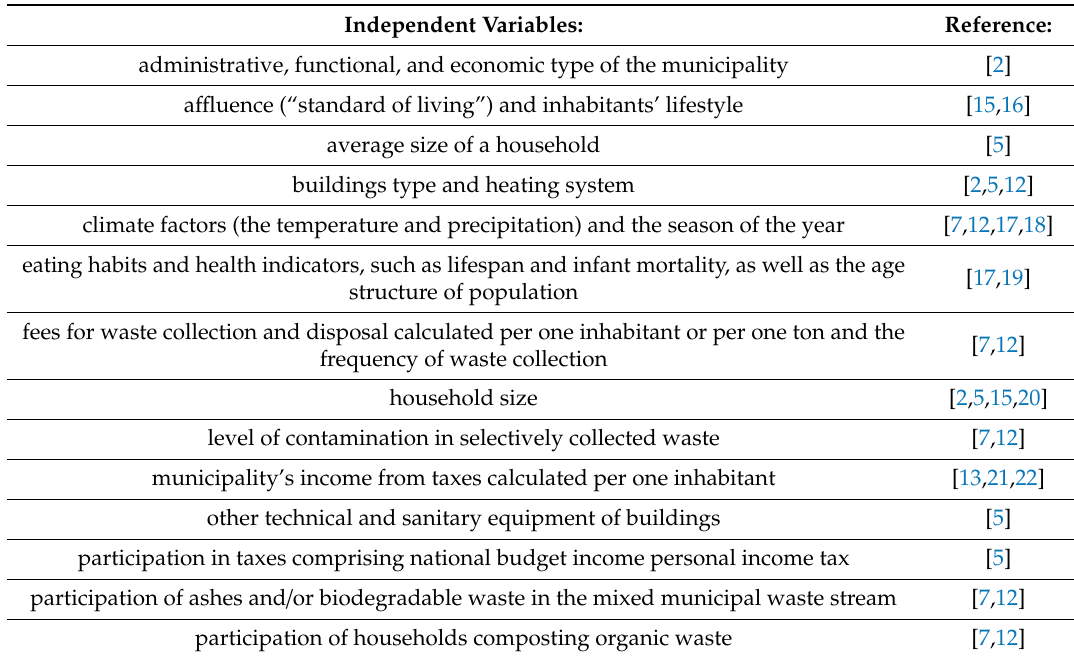
Table 1. Indicators a ff ecting the amount of waste